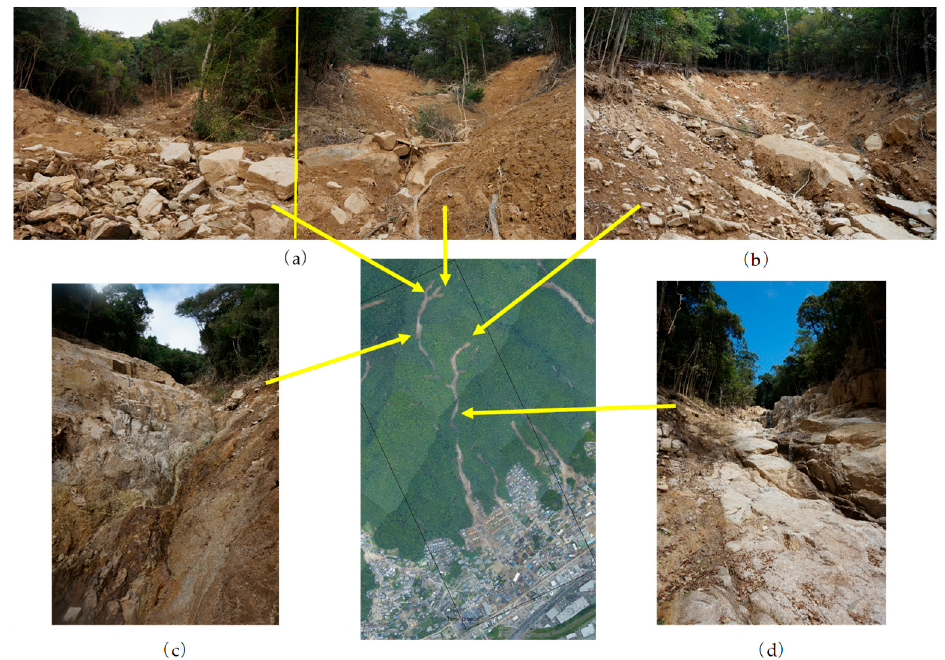
Figure 7. Eroded land surfaces and valley beds. ( a ) Upstream end of main valley, ( b ) Upstream end of tributary, ( c ) High step in the upstream reach of the main valley, ( d ) Base rocks are exposed in the middle reach of the main valley.